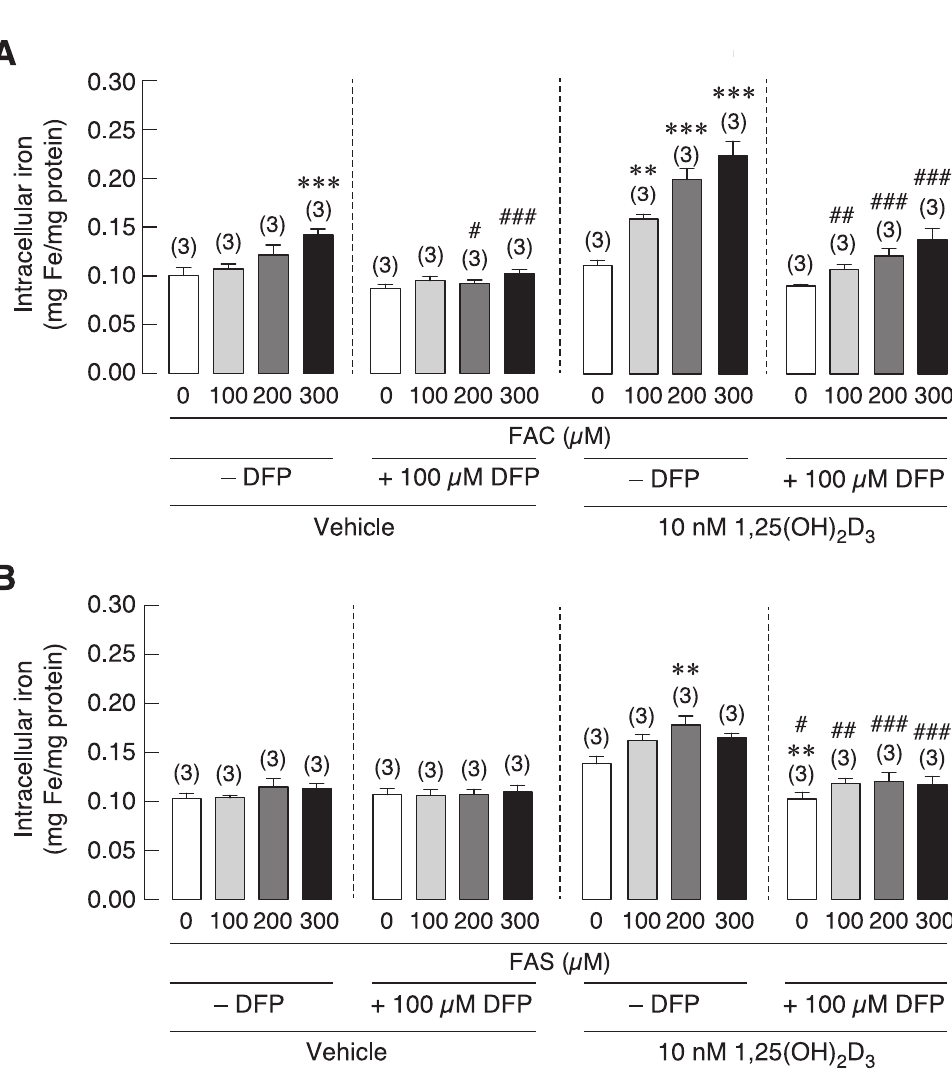
of FAC at 300 μ M could significantly raise intracellular iron in osteoblasts. No significant change was observed in other FAC or FAS treated groups; hence, the effect of DFP on the level of intracellular iron in these groups was not observed (Fig 5A). However, intracellular iron level in osteoblasts treated with 300 μ M FAC was decreased significantly from 0.14 mg/mg proteins to 0.10 mg/mg proteins in the presence of DFP (Fig 5A). On the other hand, DFP notably lowered intracellular iron under 1,25(OH) D stimulation from 0.11 to 0.09 mg/mg 2 3 proteins in control groups, from 0.16 to 0.11 mg/mg proteins in 100 μ M, from 0.20 to 0.12 mg/ mg proteins in 200 μ M and from 0.22 to 0.14 mg/mg proteins in 300 μ M FAC treated groups (Fig 5B). Similarly, intracellular iron in FAS together with 1,25(OH) D treated osteoblasts 2 3 also decreased from 0.14 to 0.10 mg/mg proteins in control groups, from 0.16 to 0.12 mg/mg